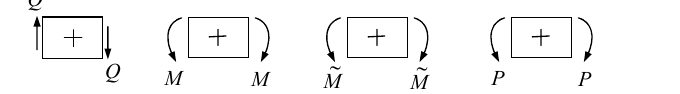
Fig. 2. Sign convention for positive shear force Q ( z ) , bending moment M ( z ) , generalized moment ˜ M ( z ) and higher-order moment P ( z ) . ϑ = cos − 1 ( ¯